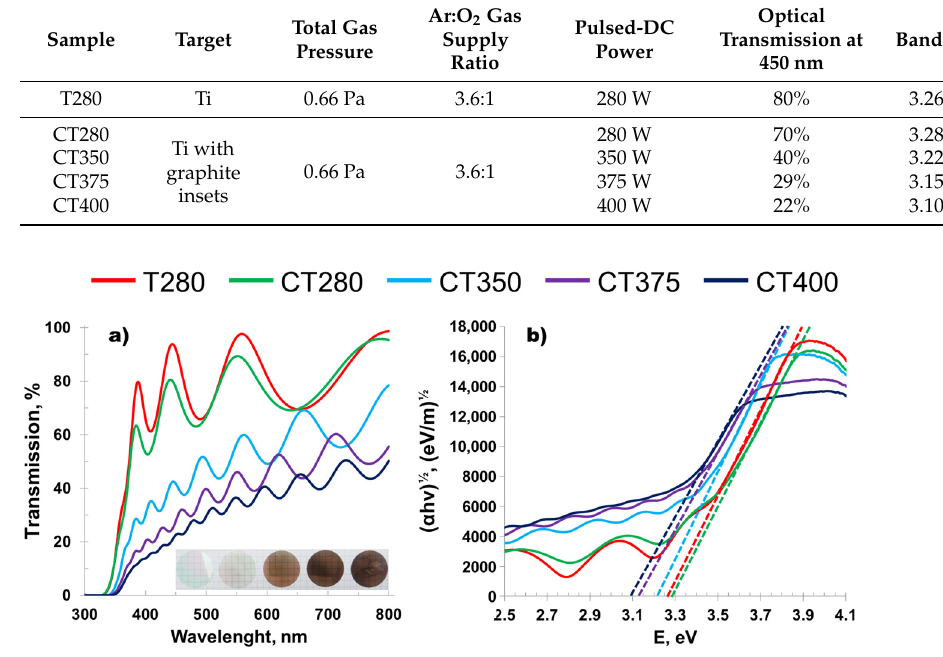
Figure 2. Optical properties of TiO 2 and C-TiO 2 films deposited using different pulsed-DC magnetron power levels: ( a ) optical transmission (inset shows natural colors of the films); and ( b ) Tauc plot.